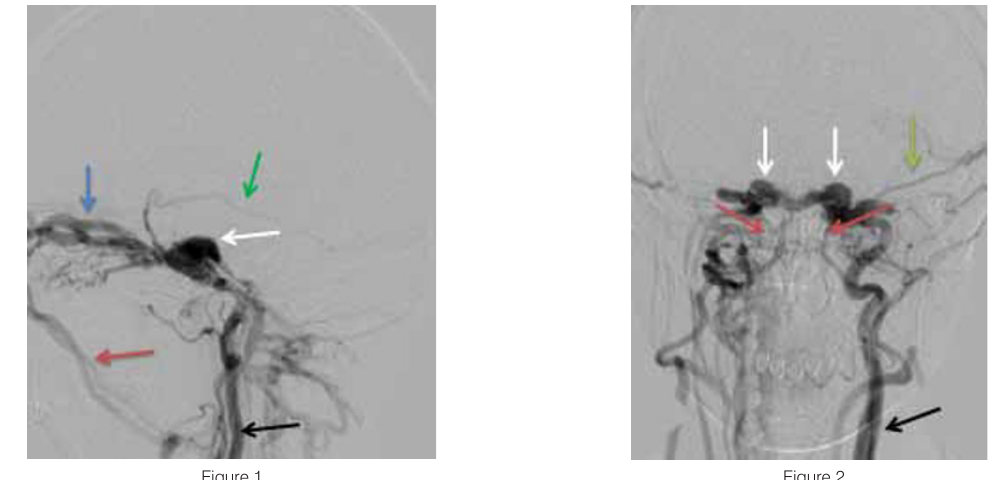
Figure 1. and 2. Lateral and anteroposterior left carotid angiogram showing high flow (CCF) with brisk shunting from the left internal carotid artery (black arrow) into the botha cavernous sinuses (white arrows) and drainage into dilated superior ophtalmic vains (blue arrow) and facial veins (red errows); and reflux into cortical veins (green errows)(a poor prognostic factor). There is no supply of the distal internal carotid artery and intracranial